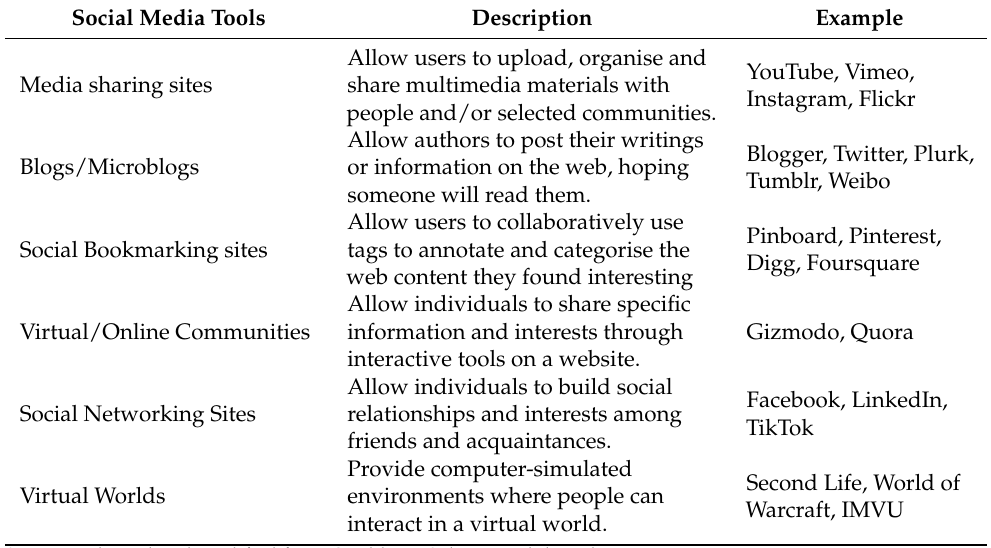
Table 1. Classification of Social Media.